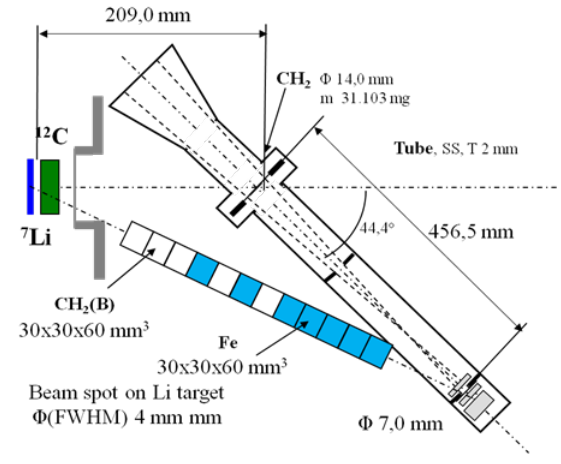
Figure 6. The proton recoil telescope